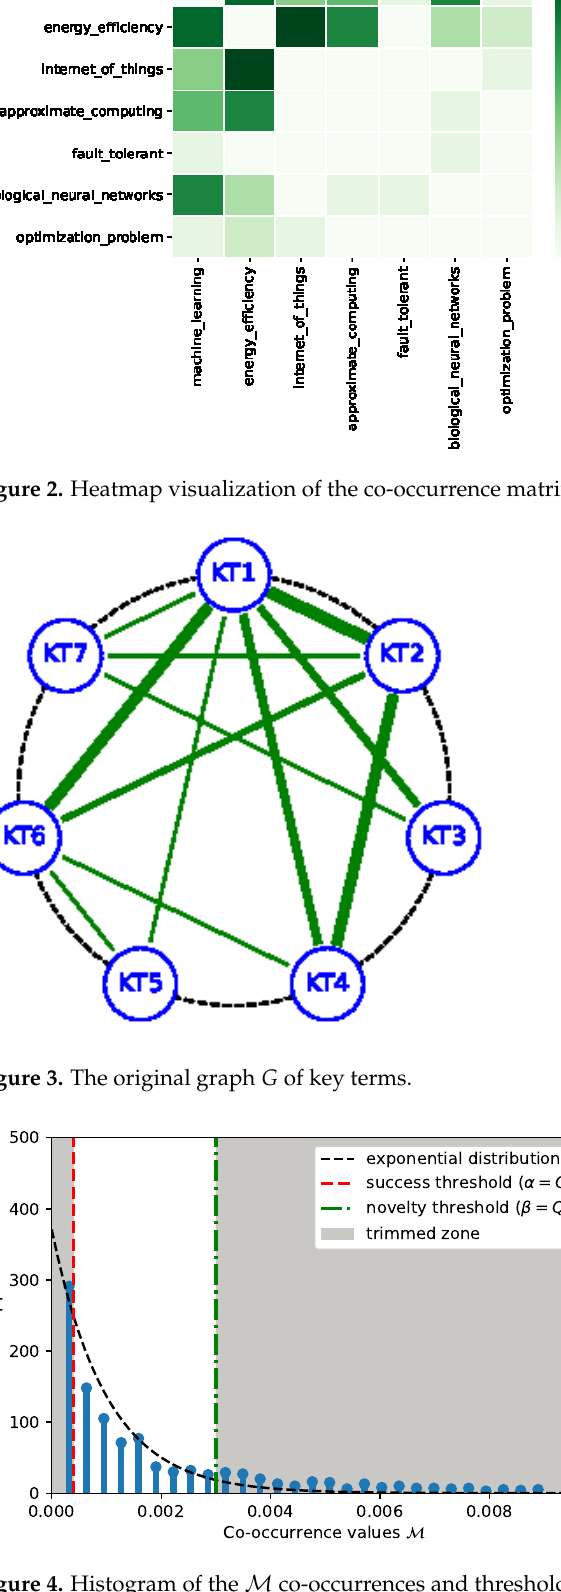
Figure 4. Histogram of the M co-occurrences and threshold values